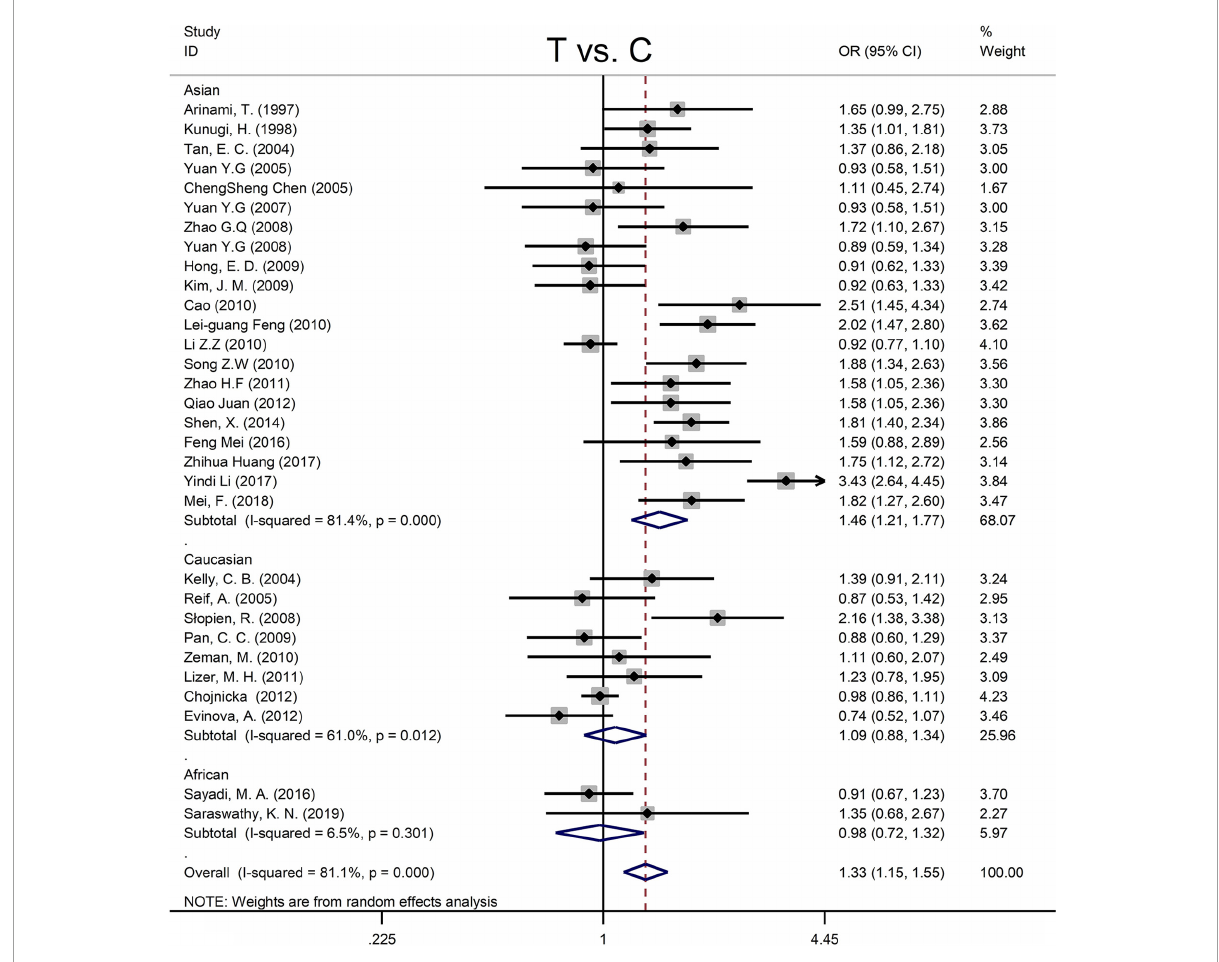
FIGURE4 Forest plots for the associations between MTHFR C677T polymorphisms and MD for the allele model with random effect model.